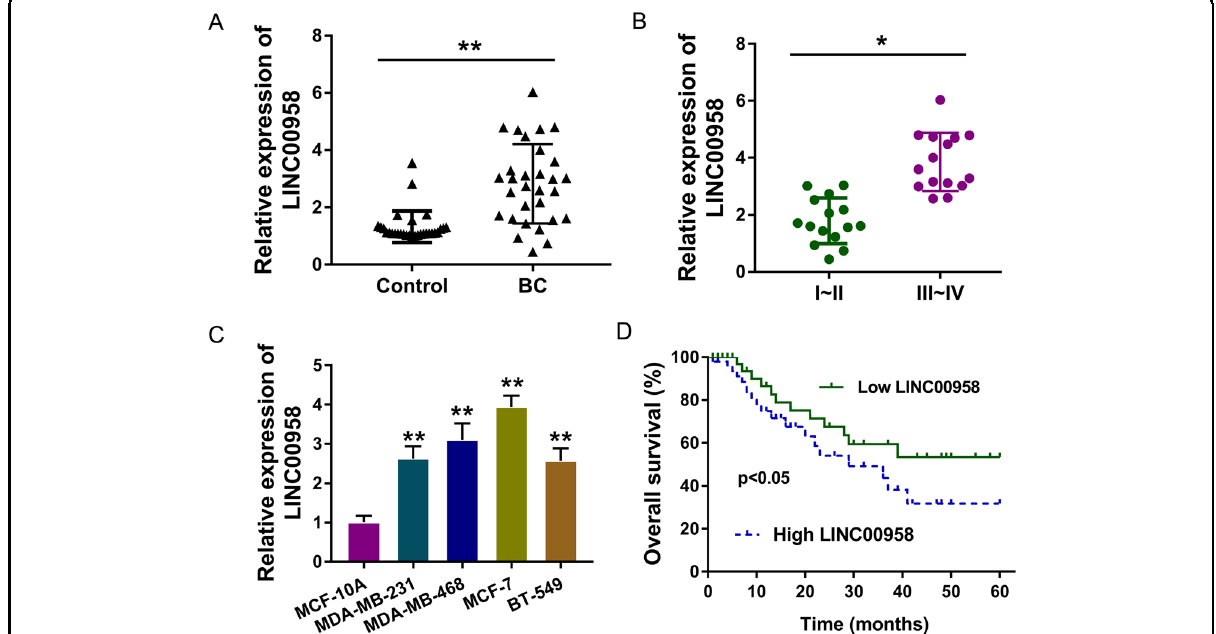
Fig. 1 LncRNA LINC00958 indicated an unfavorable prognosis for patients with BC. A The expression of LINC00958 was detected using RT-PCR in the enrolled patients with BC and control subjects. B The BC samples were divided into two groups (I/II and III/IV) according to clinical stage. RT- PCR was performed to detect LINC00958 expression. C RT-PCR indicates the levels of LINC00958 in normal mammary cells (MCF-10A) and BC cell lines (MDA-MB-231, MDA-MB-468, MCF-7, and BT-549). D Survival rate analysis reveals the unfavorable prognosis of BC clinical patients with higher LINC00958 expression. P < 0.05 was considered as signi fi